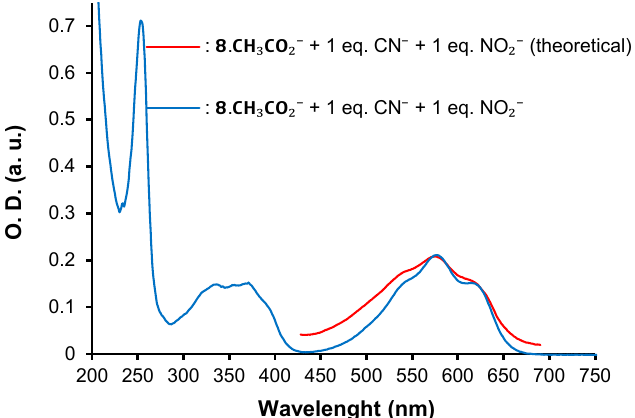
Figure 12. Theoretical (calculated) spectrum from 425 to 700 nm of 8.CH 3 CO 2 − + 1eq. CN − + 1eq. NO 2 − (red) and experimental spectrum for the same (blue) ([ 8.CH 3 CO 2 − ] 0 = ca 1.40 × 10 − 5 M). Table 3. Association constants (K i ) determined in CH 3 CN at 293 K for the host–guest complexes 8.X − .